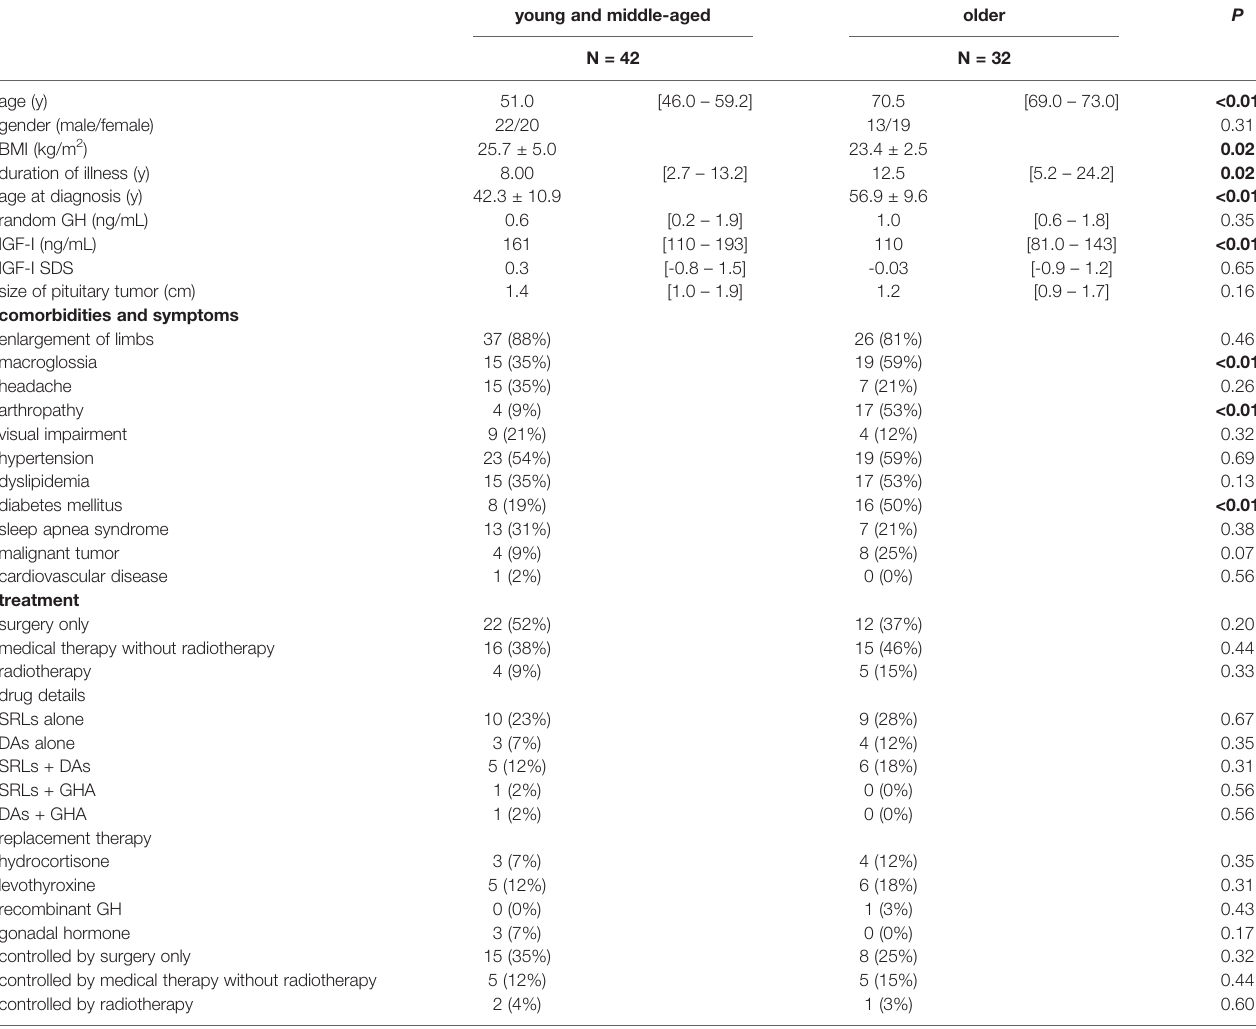
TABLE 3 | Comparison of clinical characteristics between the young and middle-aged, and the older